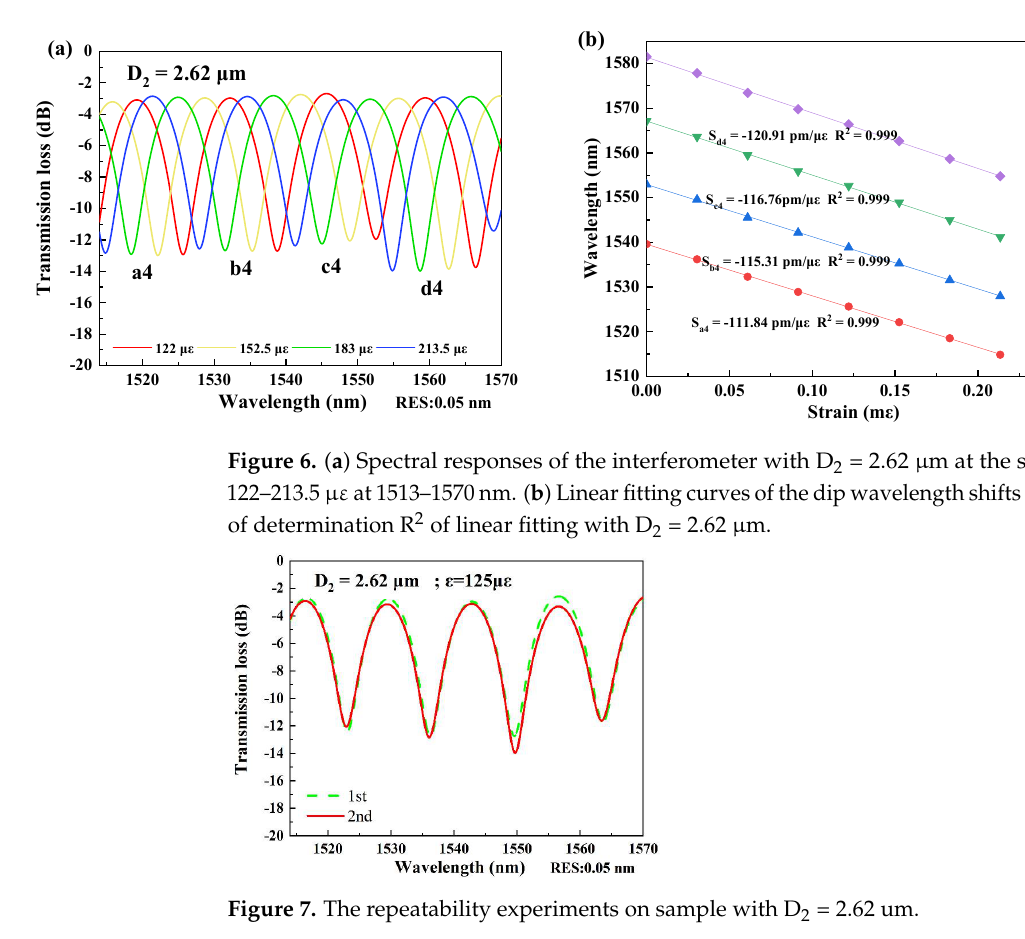
Figure 7. The repeatability experiments on sample with D 2 = 2.62 um.